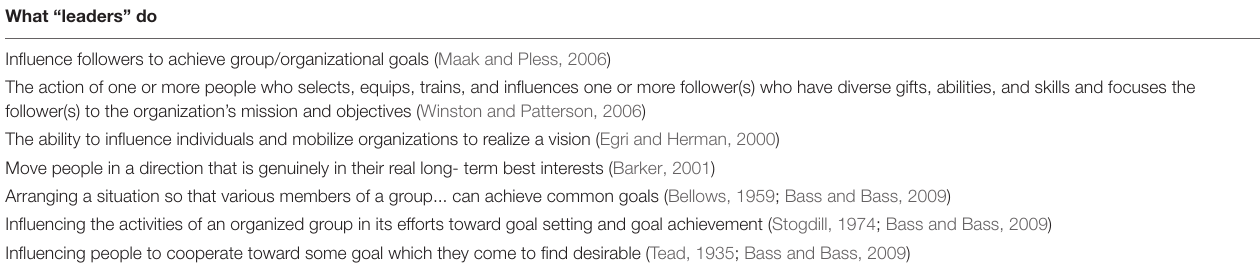
TABLE 1 | Examples of what “leaders” do. What “leaders”